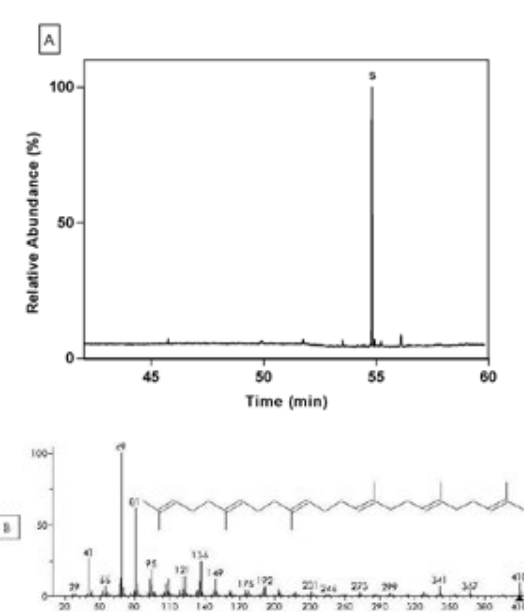
Figure 3. (A) Total Ion Chromatogram (TIC) from extracts of calluses without elicitor. The peak at 54.81 min (s) cor - responds to squalene. (B) MS spectra of squalene.